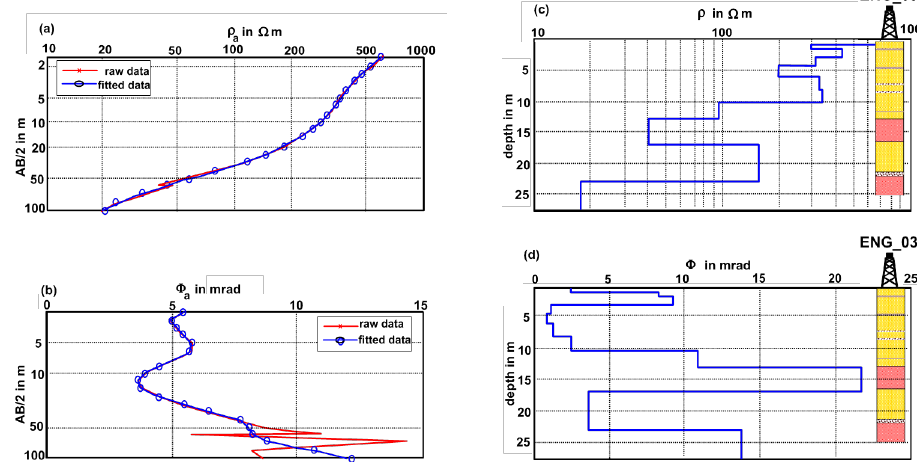
Fig. 2. SIP sounding inversion results. Apparent resistivity amplitude (a) and phase angle (b) data and the inversion results (c and d , respectively) in comparison with well ENG_03 (see Fig. 1).